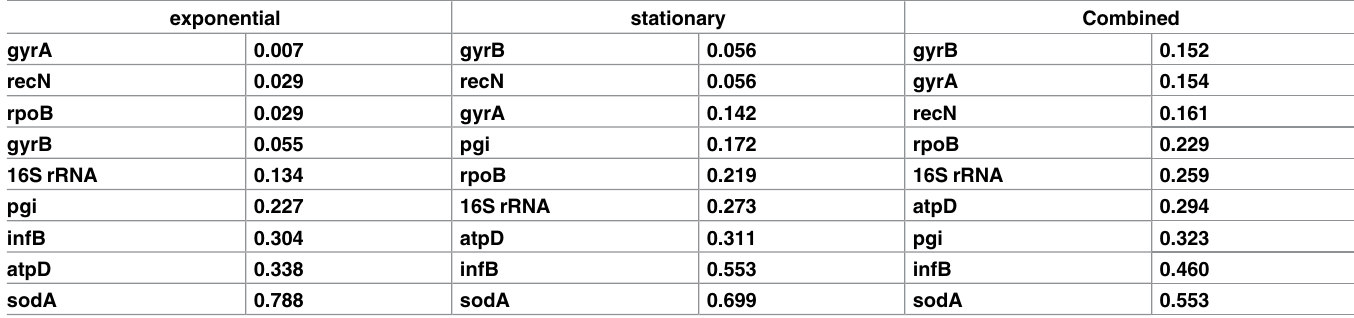
Table 7. Gene expressionstability rankings for different growth phase in A . paragallinarum serovarC analyzed by NormFinder. exponential stationary